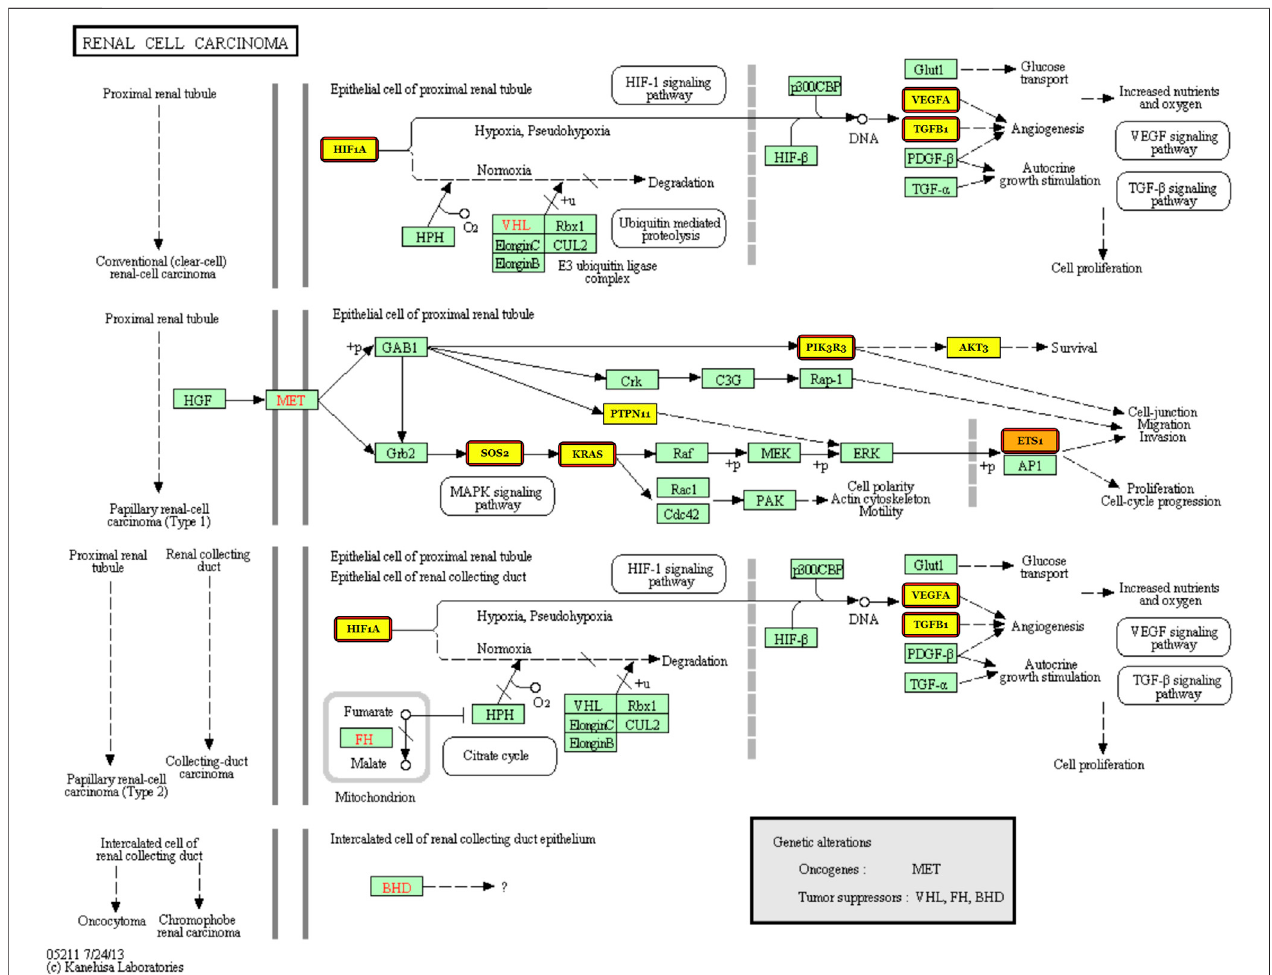
FIGURE 7 | Renal cell carcinoma pathway with the targets regulated by miR-140, miR-1270, and miR-570 labeled.